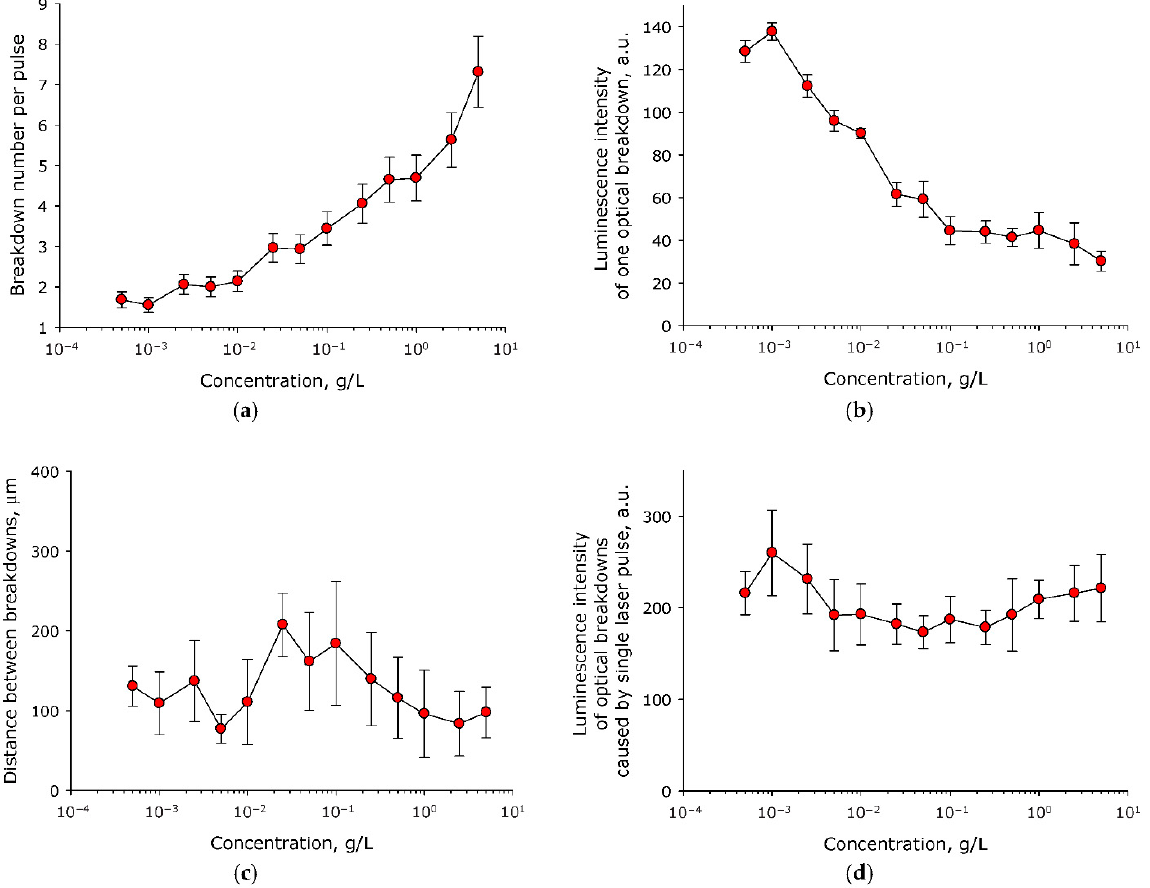
Figure 1. Effect of the concentration of BSA molecules in aqueous solution on the characteristics of optical breakdown plasma ( n = 3, Mean ± SEM). ( a ) Effect of the concentration of BSA molecules in an aqueous solution on the number of optical breakdowns caused by a single laser pulse. ( b ) Effect of the concentration of BSA molecules in aqueous solution on the average luminescence intensity of individual optical breakdown. ( c ) Effect of the concentration of BSA molecules in an aqueous solution on the average distance between optical breakdowns caused by a single laser pulse. ( d ) Effect of the concentration of BSA molecules in an aqueous solution on the average luminescence intensity of optical breakdowns induced by a single laser